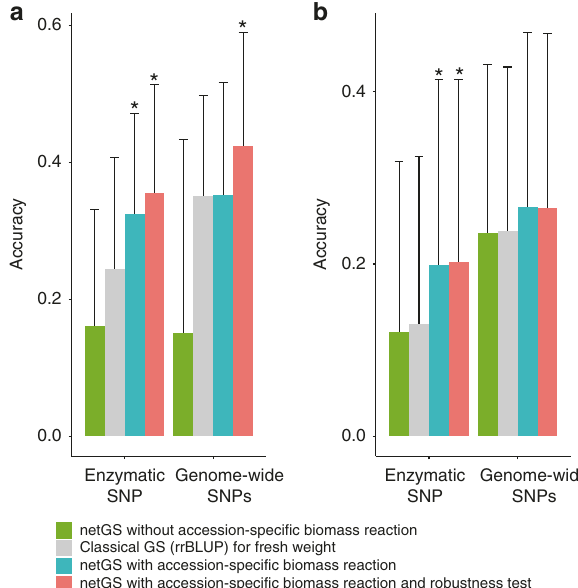
netGS without accession-specific biomass reaction Classical GS (rrBLUP) for fresh weight netGS with accession-specific biomass reaction netGS with accession-specific biomass reaction and robustness test Fig. 3 Comparison of GS prediction accuracies for growth. The predictions for growth are performed based on the classical GS (rrBLUP approach, gray), netGS using biomass reaction speci fi c to Col-0 only (green), netGS using accession-speci fi c biomass reaction (blue), and netGS with additional robustness analysis (red). The prediction accuracies are measured by the mean values of Pearson correlation coef fi cient between measure and predicted biomass using either enzymatic SNPs or genome-wide SNPs with 150 cross-validations (i.e. 50 repetitions of 3-fold cross-validation). The comparison is presented for two scenarios: ( a ) the optimal N condition and ( b ) the low N condition using metabolic models based on data from optimal N condition. The prediction accuracies of netGS with accession-speci fi c biomass reaction is signi fi cantly higher than the classical GS using enzymatic SNPs ( p- value = 6.28 × 10 − 6 within optimal N condition and p- value = 2.72× 10 − 6 from optimal N to low N condition, two-sided paired t- test, n = 150 cross-validations, *denotes signi fi cant at level 0.01). Data are presented as mean values and standard deviation (s.d.). Source data are provided as a Source Data fi